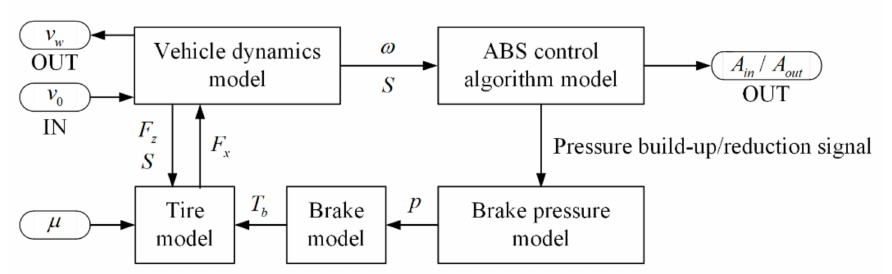
Figure 4. Structure of wheel speed simulation